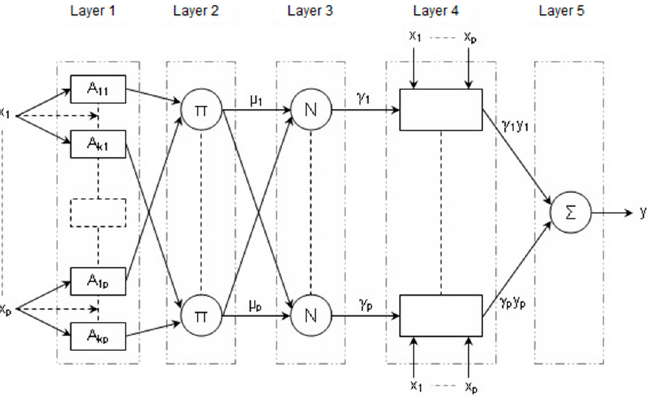
Figure 3. The architecture of